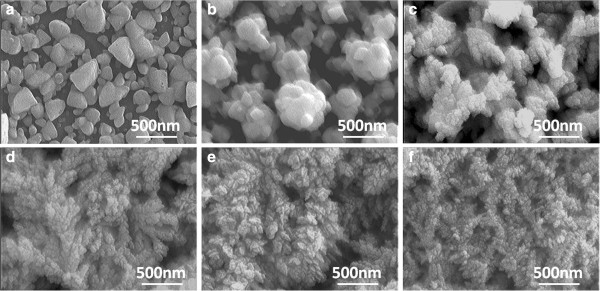
SEM micrographs of formula 0.01 M Bi(NO3)3-5H2O, 0.01 M SbCl3, and 0.01 M TeCl4. SEM micrographs of the electrolyte formula 0.01 M Bi(NO3)3-5H2O, 0.01 M SbCl3, and 0.01 M TeCl4, as a function of reduced voltage (a) 0 V, (b) -0.2 V, (c) -0.3 V, (d) -0.4 V, (e) -0.5 V, and (f) -0.6 V.